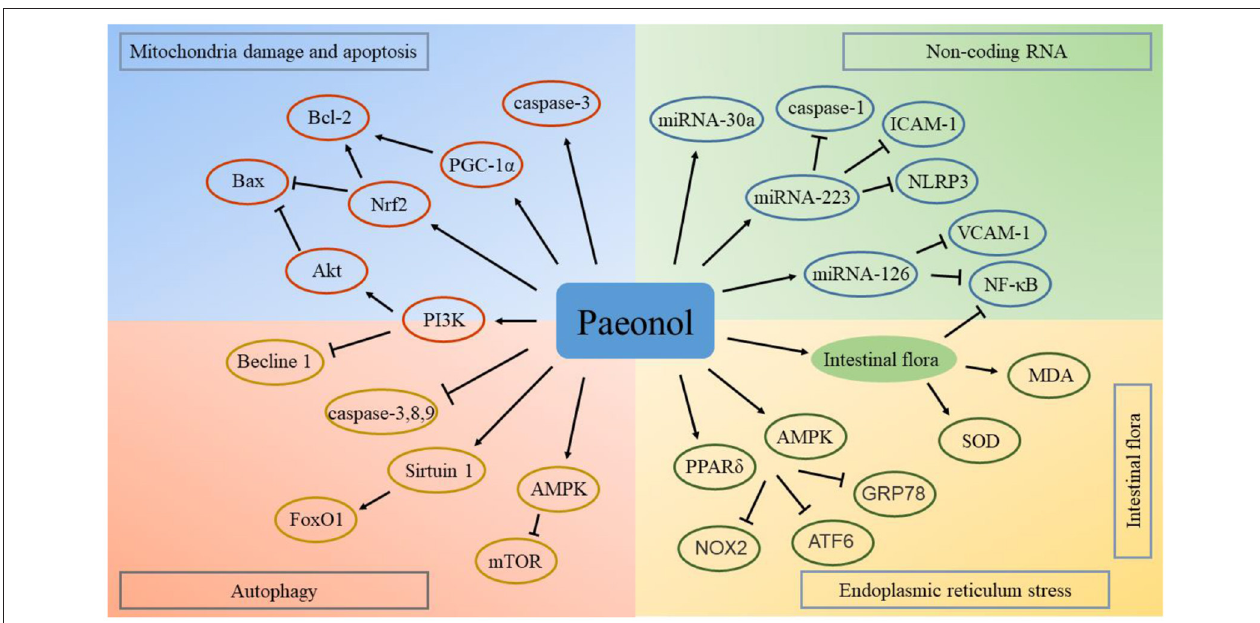
FIGURE 5 | Potential targets and mechanisms of paeonol in the treatment of atherosclerotic cardiovascular disease. ATF6, activating transcription factor 6; AMPK, adenosine monophosphate-activated protein kinase; Bax, Bcl-2 associated protein X; GRP78, glucose-regulated protein 78; ICAM, intercellular adhesion molecule; MDA, malonaldehyde; mTOR, mechanistic target of rapamycin; NOX2, nicotinamide adenine dinucleotide phosphate oxidase; Nrf2, nuclear factor erythroid 2-related factor; NF- κ B, nuclear factor-kappa B; NLRP3, nucleotide binding oligomerization domain-like receptor family pyrin domain containing 3; PPAR, peroxisome proliferator-activated receptor; PGC, peroxisome proliferator-activated receptor γ coactivator; PI3K, phosphoinositide 3-kinase; SOD, superoxide dismutase; VCAM, vascular cell adhesion